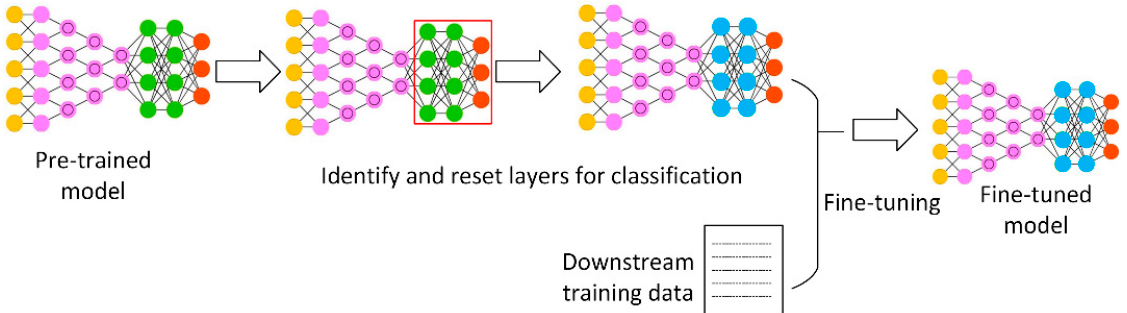
Figure 2. A typical process of network-based deep transfer learning.